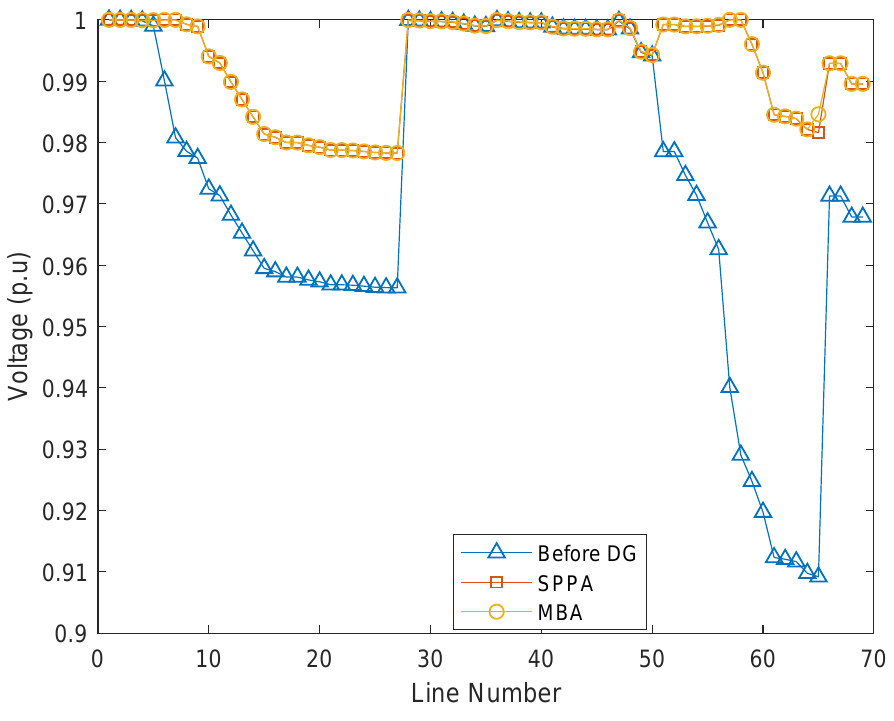
Figure 6. Bus voltage profile of